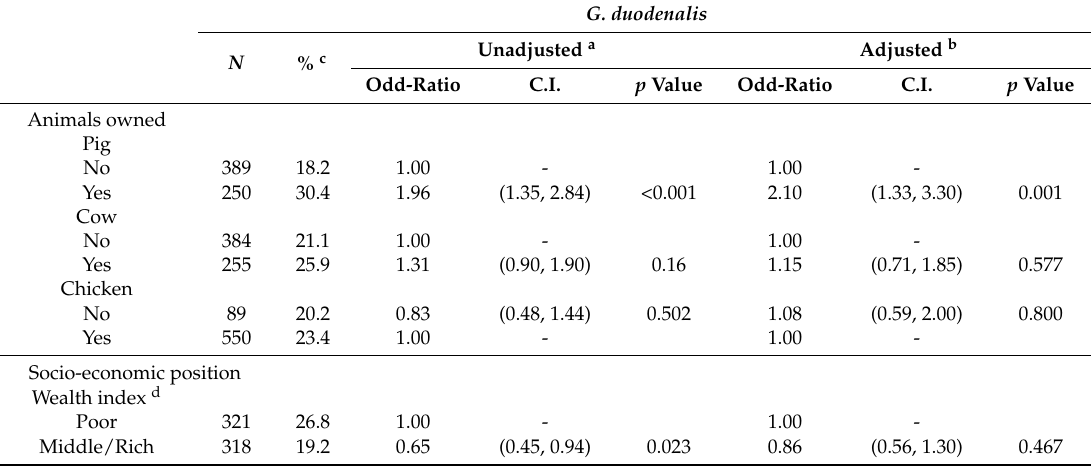
Table 2. A logistic regression model explaining the presence of G. duodenalis in